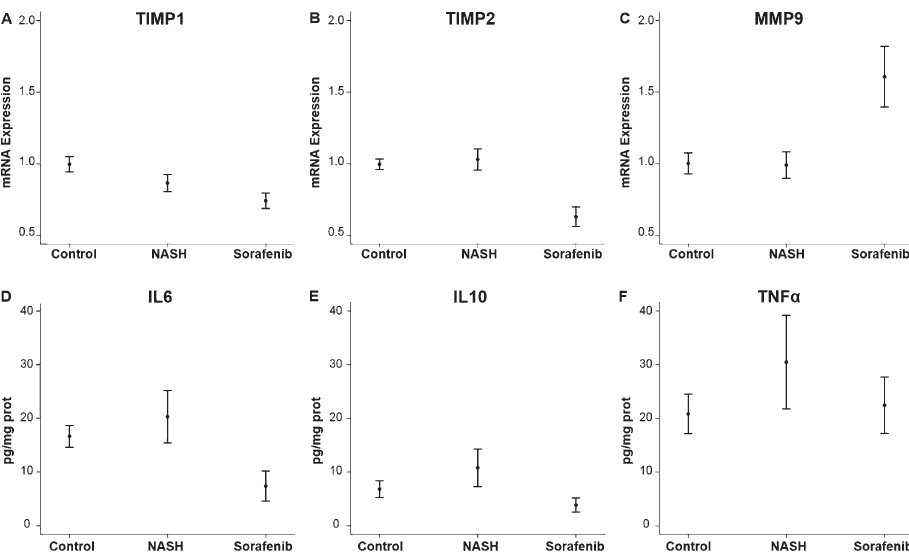
Figure 2. A , B , C , Graphic representation of TIMP1 , TIMP2 , and MMP9 mRNA expression in control (n=4), nonalcoholic steatohepatitis (NASH; n=10), and sorafenib-treated animals (n=10). A , TIMP1 mRNA expression was significantly lower in NASH animals compared to control (P= 0.036, Tukey test) and further impaired in sorafenib-treated rats (P , 0.001 vs control and P=0.015 vs NASH, Tukey test). B , TIMP2 was significantly lower in the sorafenib group compared to control and NASH groups (P , 0.001, Tukey test). C , MMP9 mRNA content was increased in animals treated with sorafenib (P , 0.001 vs control and NASH, non-parametric Tukey test). There was no statistical difference in MMP9 mRNA transcription levels in the liver from NASH animals compared to control rats (P= 0.834, non-parametric Tukey test). D , E , F , Graphic representation of IL-6, IL-10, and TNF- a in control, NASH, and sorafenib- treated animals. D , Protein levels of IL-6 were similar in the NASH and control groups (P=0.55, Tukey test). IL-6 levels were significantly lower in sorafenib animals compared to NASH animals (P=0.002, Tukey test). E , IL-10 protein levels were also lower in the sorafenib group compared to the NASH (P , 0.001, non-parametric Tukey test) and control groups (P=0.039, non-parametric Tukey test). F , No differences in TNF- a protein levels were detected among the three groups (non-parametric Tukey